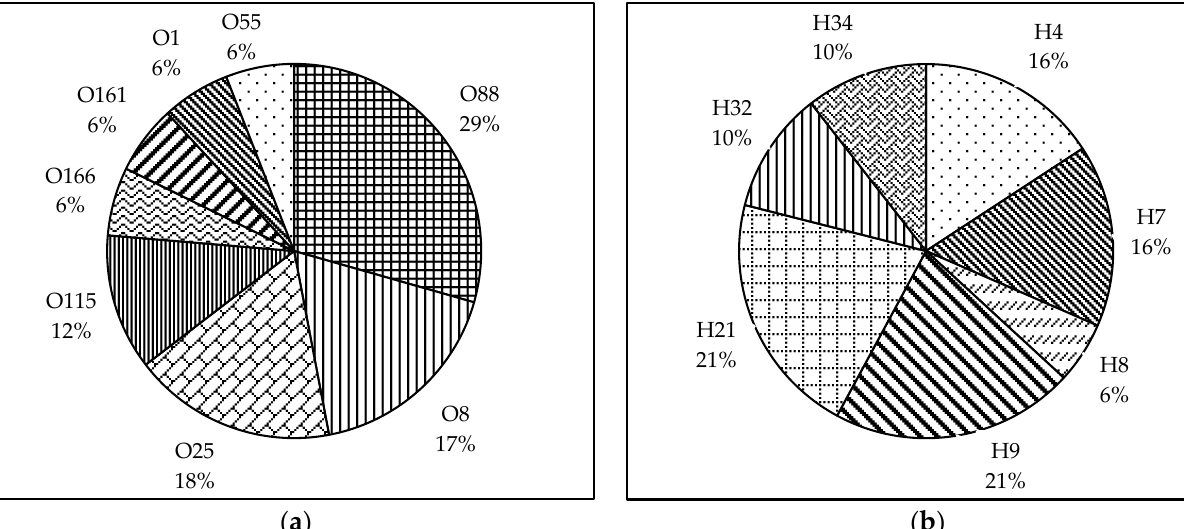
Figure 1. Pie charts showing the prevalence of O and H serogroups among the broiler breeder APEC isolates. ( a ) The O-serogroups identified among the typed isolates were O88, O8, O25, O115, O166, O161, and O1. ( b ) The H serogroups identified among the typed isolates were H4, H7, H8, H9, H21, H32, and H34. Data represented as the percentage of prevalence.